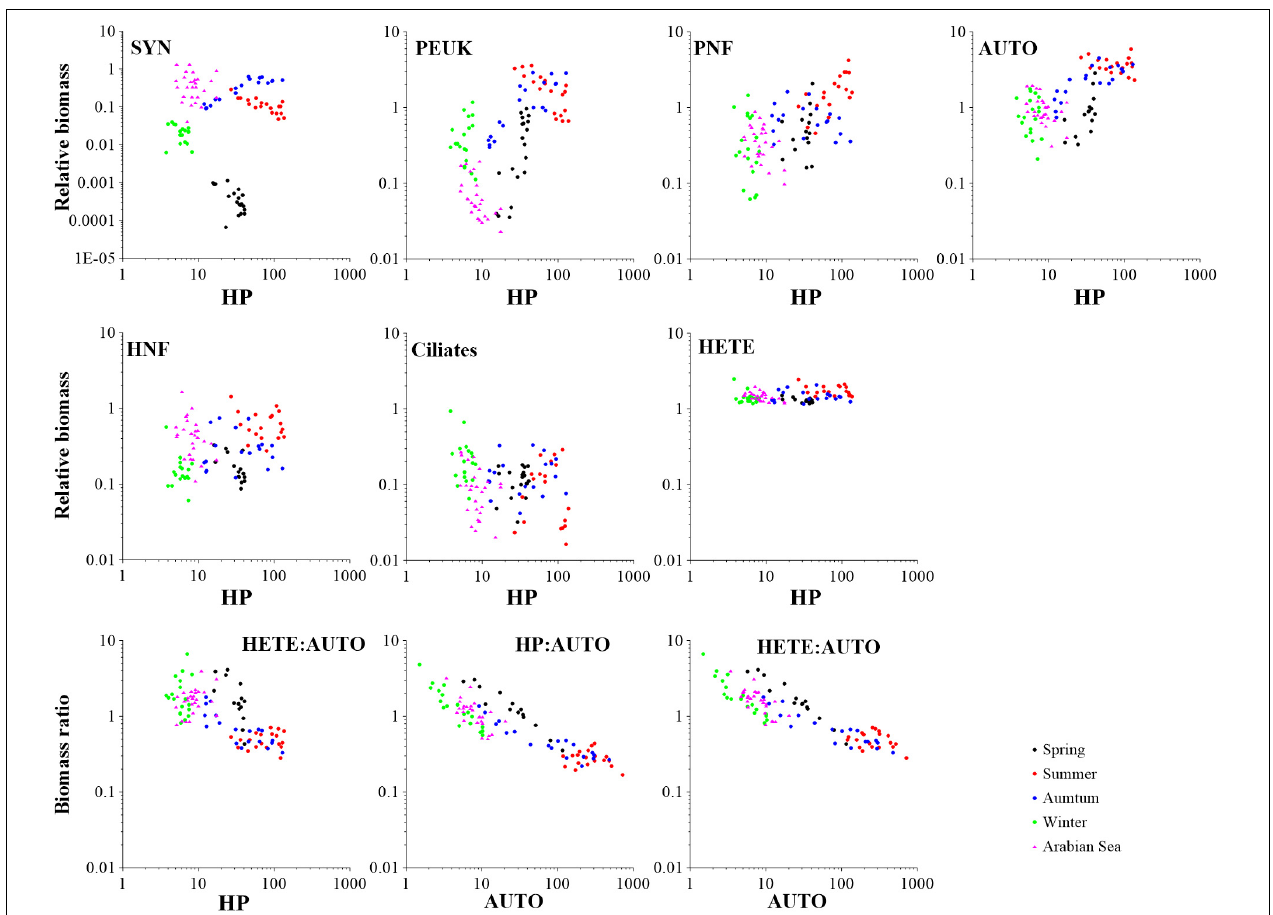
FIGURE 5 | Microbial food web component biomass variations relative to HP biomass ( µ g C dm − 3 ) changes. HETE to AUTO biomass ratio variations as a function of HP biomass increase and AUTO biomass ( µ g C dm − 3 ) in Sanggou Bay and Arabian Sea. The data of Arabian Sea were extracted from Garrison et al. (2000). HP, heterotrophic prokaryotes; SYN, Synechococcus ; PEUK, phototrophic picoeukaryotes; PNF, pigmented nanoflagellates; HNF, heterotrophic nanoflagellates; AUTO, autotrophic organisms; HETE, heterotrophic organisms.